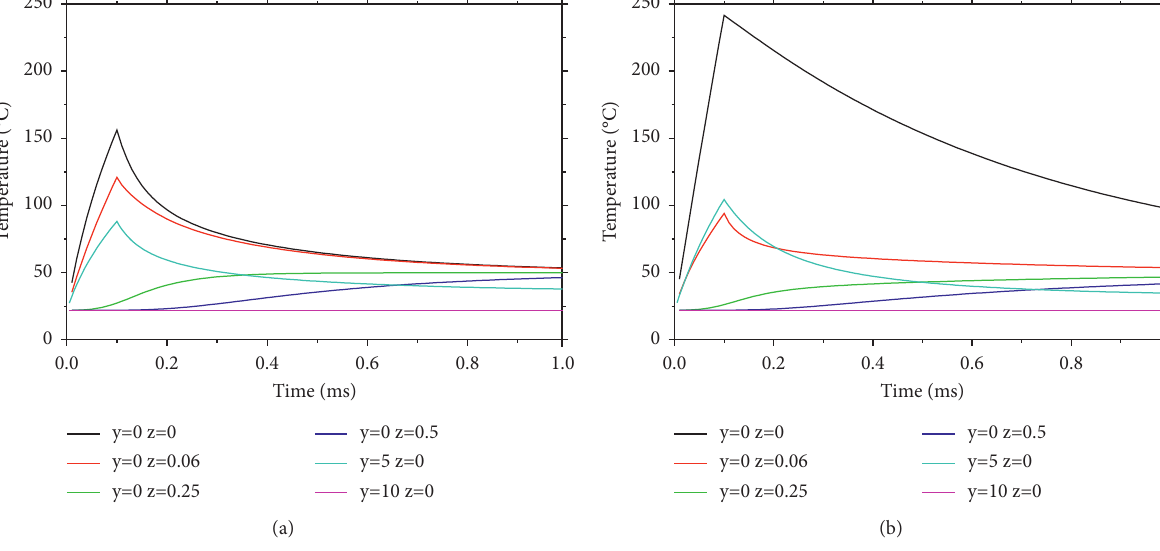
Figure 4: ANSYS-simulated time-dependent temperature evolution of a 0.5mm-thick isotropic graphite disc for 1ms after the impact of a 100 μ s-long U-ion pulse. Coordinates can be seen in Figure 3, with all points being at x � 0. (a) Pristine material. (b) Thermal conductivity reduced to 4 W/m · K in the material of the beam spot representing graphite after 1.14GeV U-ion irradiation to a fluence of 3 × 10 13 ions/cm 2